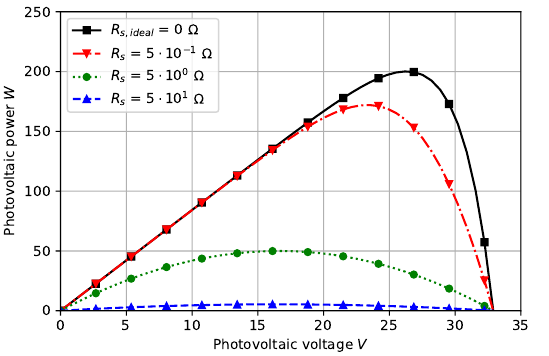
Figure 4. Behavior of the power as a function of the voltage as R s is adjusted on the SDM considering R sh → ∞ Ω .